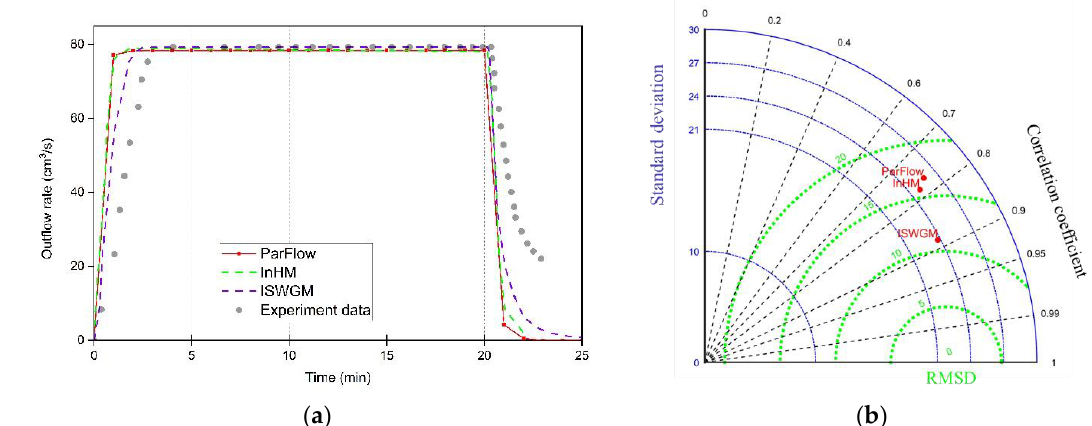
Figure 12. Outflow response comparison among ParFlow, InHM, ISWGM and experiment for the 2D sandbox case: ( a ) Time-series comparison plots; ( b ) Taylor diagram for ParFlow, InHM and ISWGM, including SD, R and RMSD.